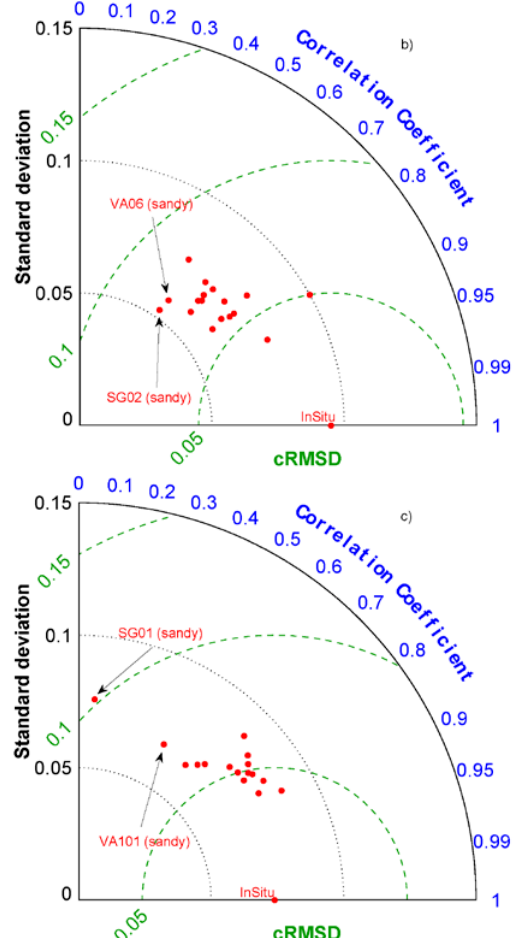
Figure 3. Results of the comparison between each station in: a) the REMEDHUS network, b) the Inforiego-2012 network, c) the Inforiego-2013 network and its corresponding L2 ascending DGG. Only stations with results discussed in the text are